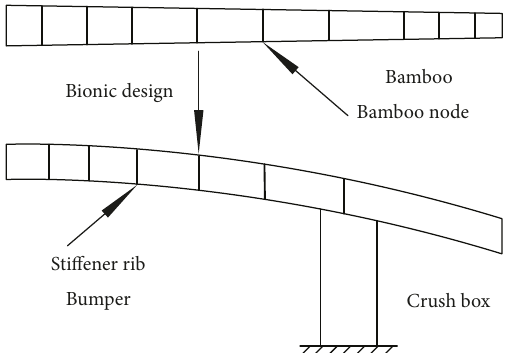
Figure 9: The design idea of the Bionic1 and Bionic2 bumper